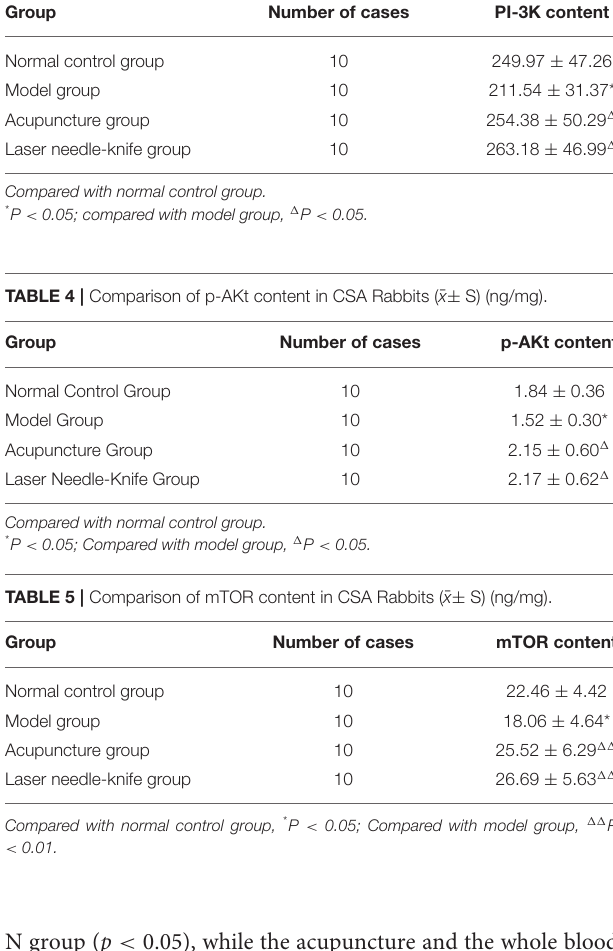
rabbits per group are shown in Table 4 . p-AKt concentration was significantly lower in the model group than in the normal control group ( p < 0.05), but was similar between the acupuncture, laser needle knife, and normal control groups ( p > 0.05). p-AKT concentration was significantly higher in the acupuncture